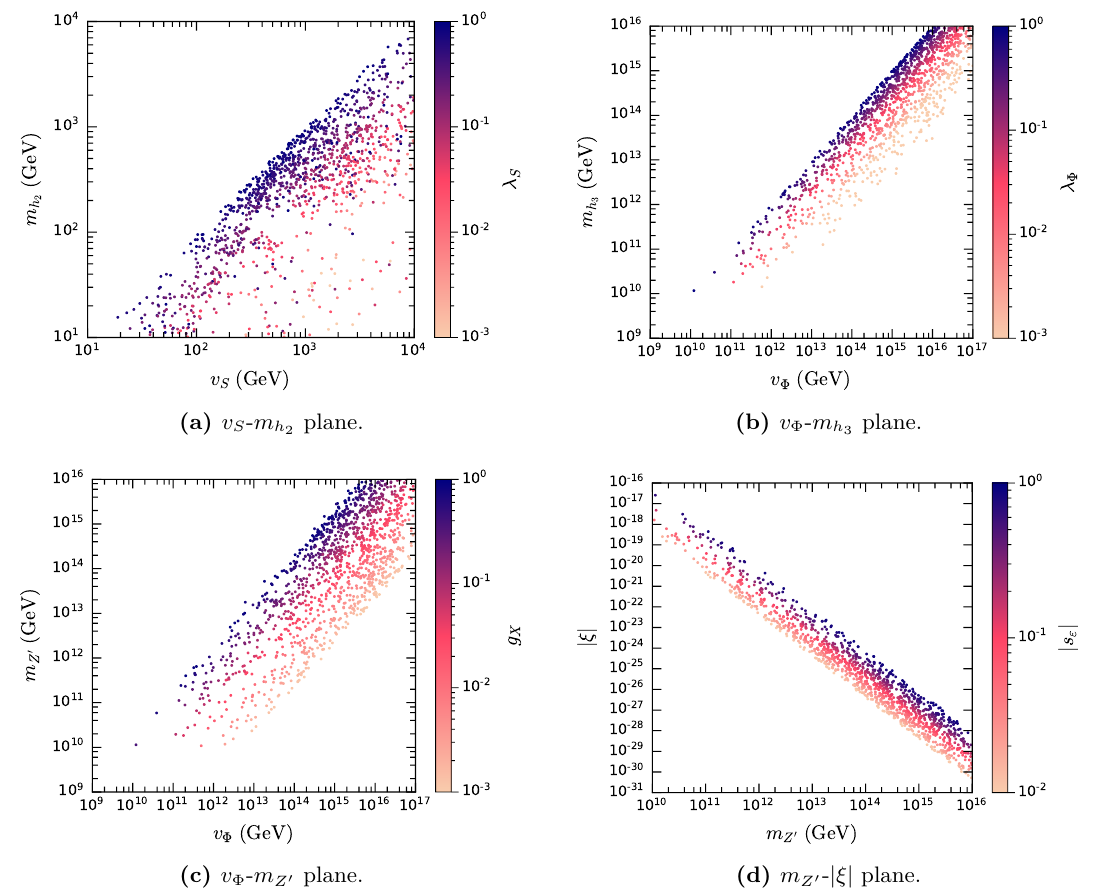
(a), v - m (b), v - m (c), and Φ h 3 Φ Z 0 2